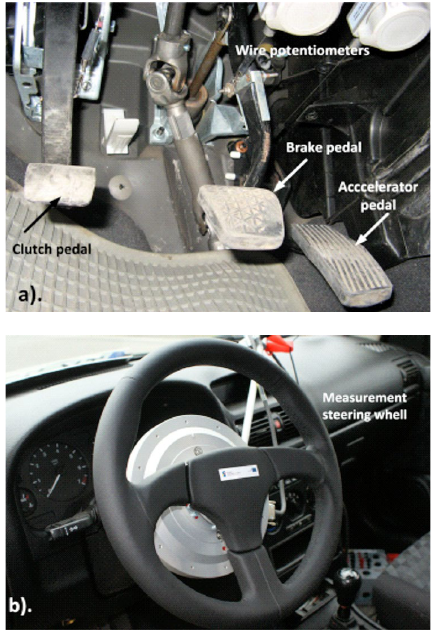
Fig. 10. View of the measuring equipment